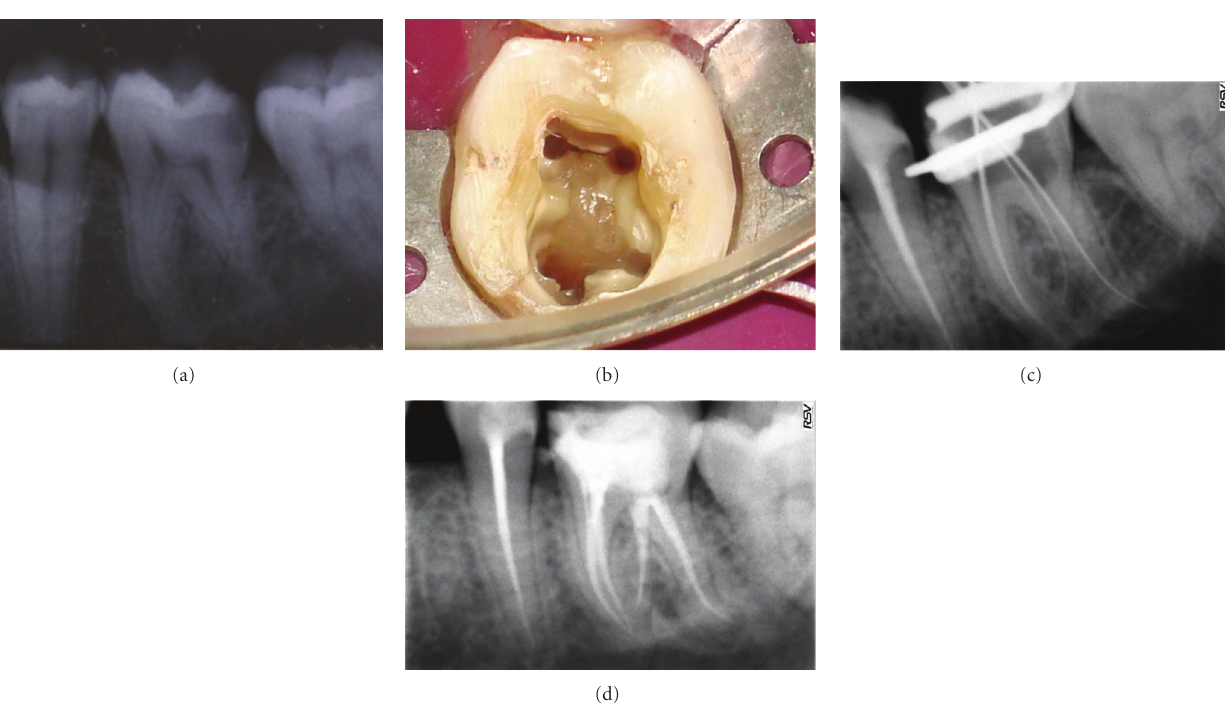
Figure 3: (a) Diagnostic radiograph, (b) access cavity preparation, (c) working length determination, and (d)